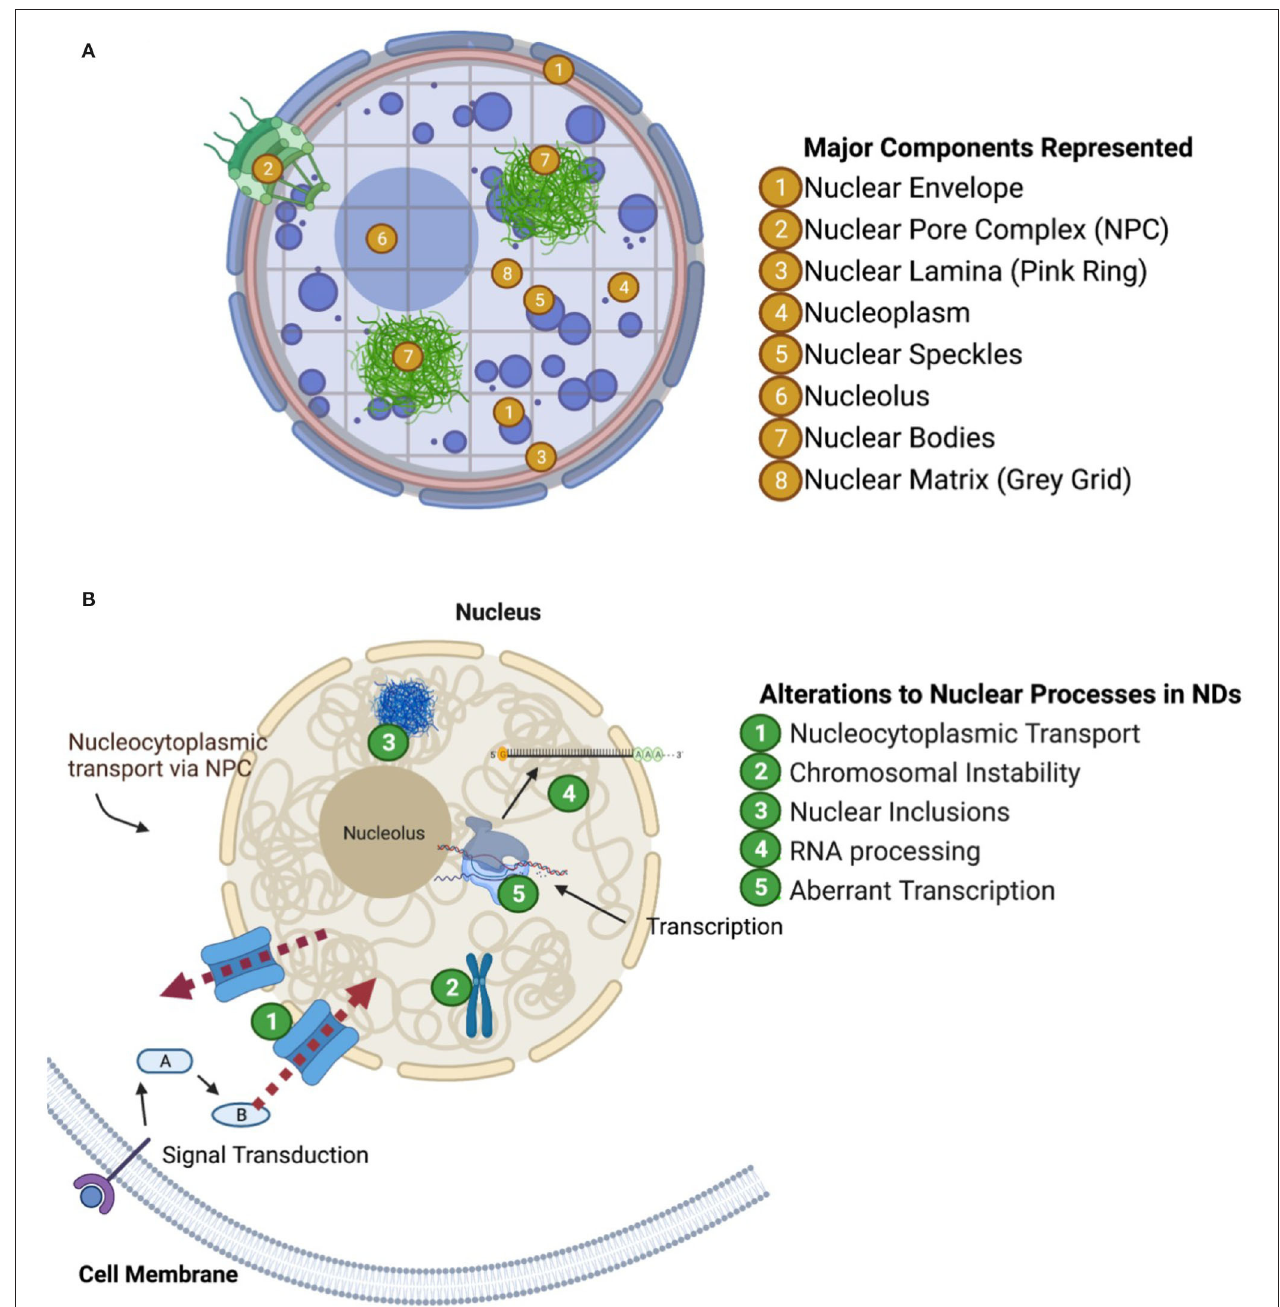
FIGURE 1 | Nuclear compartments and functional groups of proteins perturbed in neurodegenerative diseases. (A) Visualization of nuclear structures (one way to characterize nuclear proteins). (B) Visualization of aberrant nuclear mechanisms in neurodegeneration as discussed in paper.